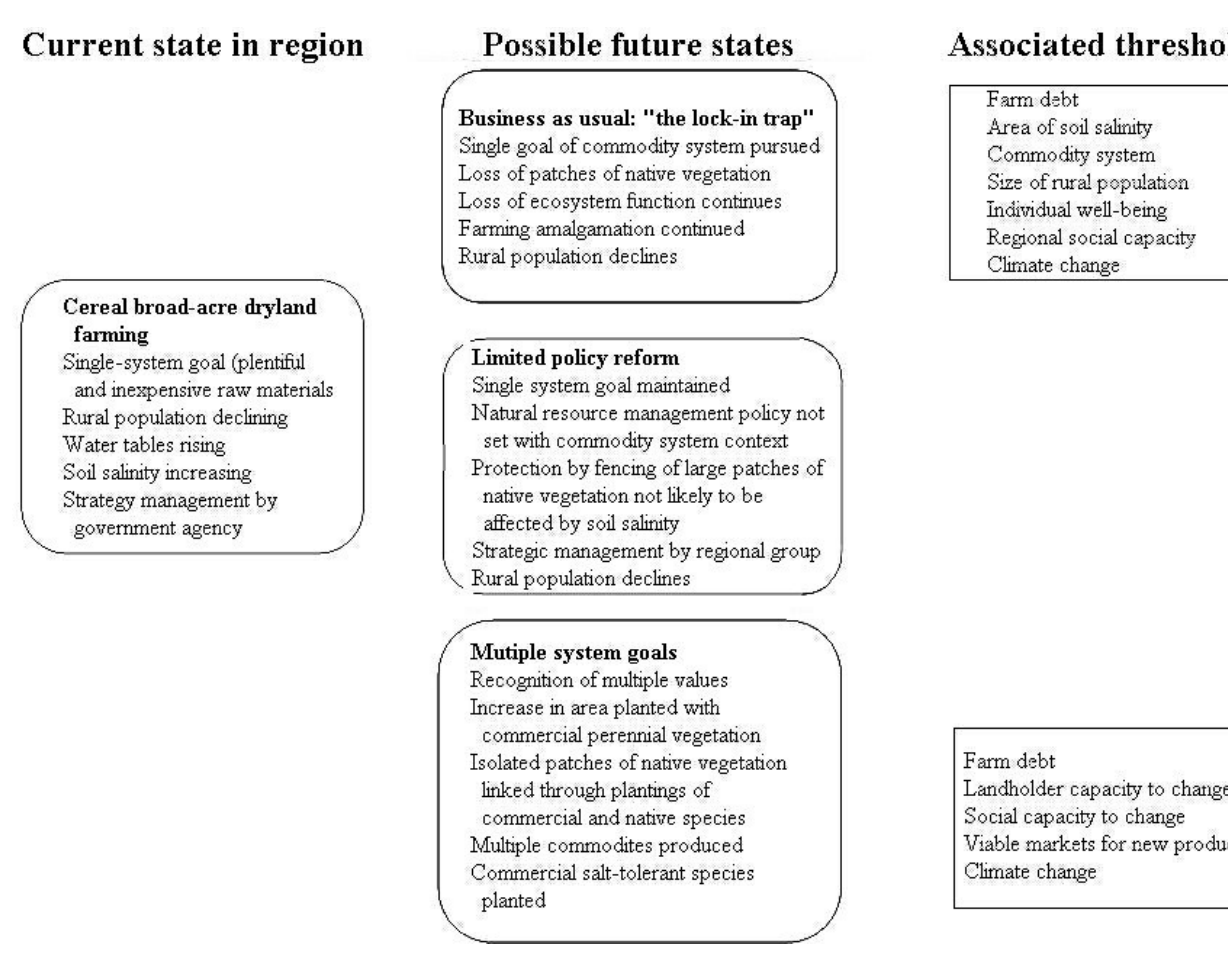
Fig. 6 . The current and possible future states in the western Australian wheatbelt and some of the key